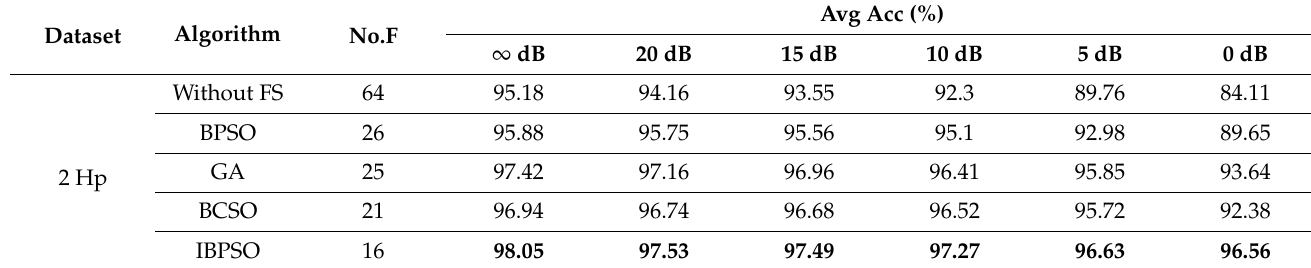
Table 12. Classification results using FCNN-B.